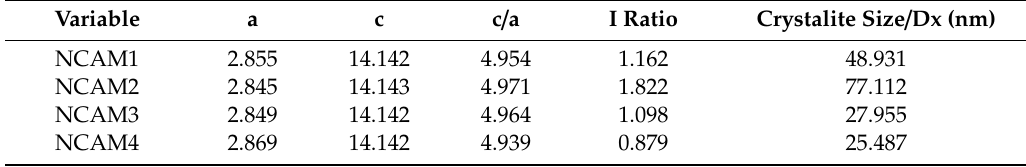
Table 4. Structural parameter of NCA samples at various precursor solution concentrations.